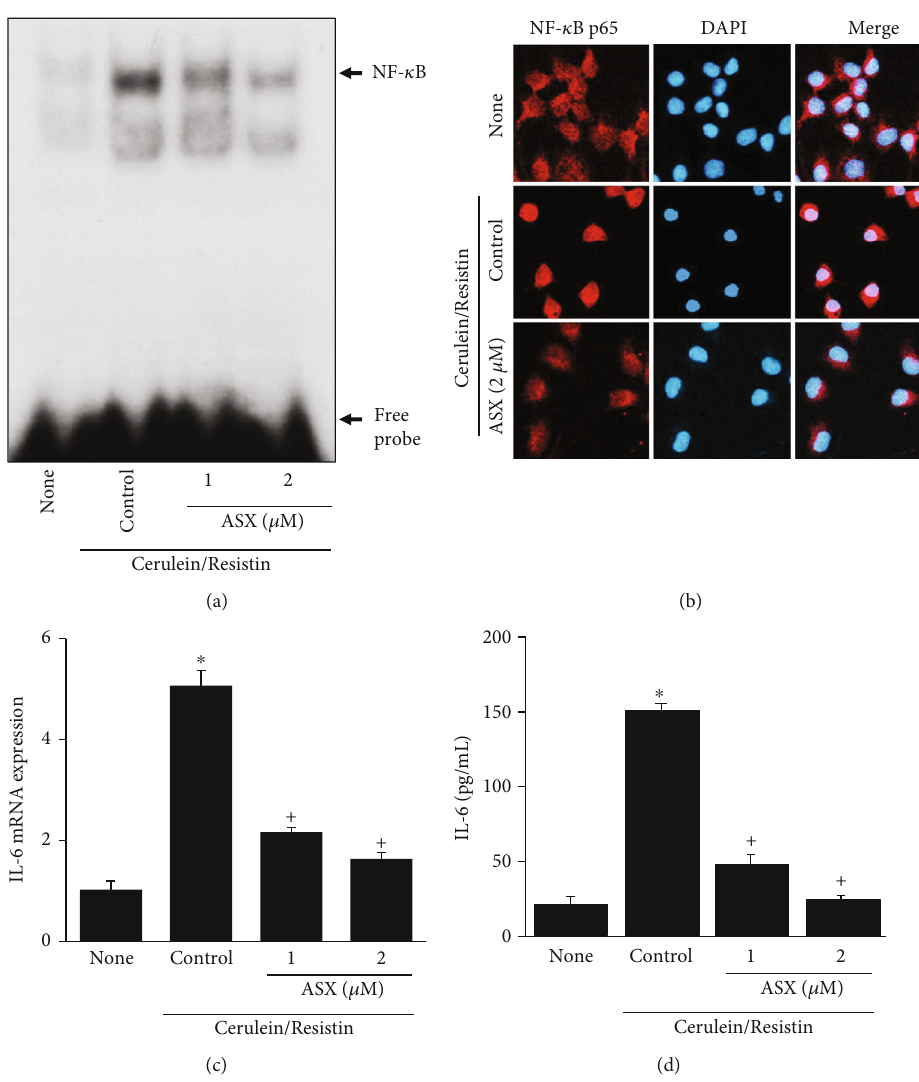
Figure 5: Astaxanthin (ASX) inhibits cerulein/resistin-induced NF- κ B activation and IL-6 expression in AR42J cells. The cells were pretreated with the indicated concentrations of ASX for 3 h and then stimulated with cerulein/resistin for 1h (for NF- κ B-DNA binding activity and nuclear level of NF- κ B p65 by confocal images (a, b)), for 6h (for IL-6 mRNA level (c)), and 24h (for IL-6 protein level (d)). (a) NF- κ B-DNA binding activity was determined by electrophoretic mobility shift assay (EMSA). (b) The immunoreactive NF- κ B p65 was visualized using a rhodamine-conjugated mouse anti-rabbit IgG antibody (red) with DAPI counterstaining (blue) of the same fi eld. (c) The mRNA expression level of IL-6 was determined by real-time PCR analysis and normalized to that of β -actin. (d) The protein level of IL-6 in the media was determined by enzyme-linked immunosorbent assay (ELISA). Data are expressed as the mean ± S : E : of three di ff erent experiments. ∗ p < 0 : 05 vs. none (untreated cells); + p < 0 : 05 vs. cerulein (cells treated with cerulein